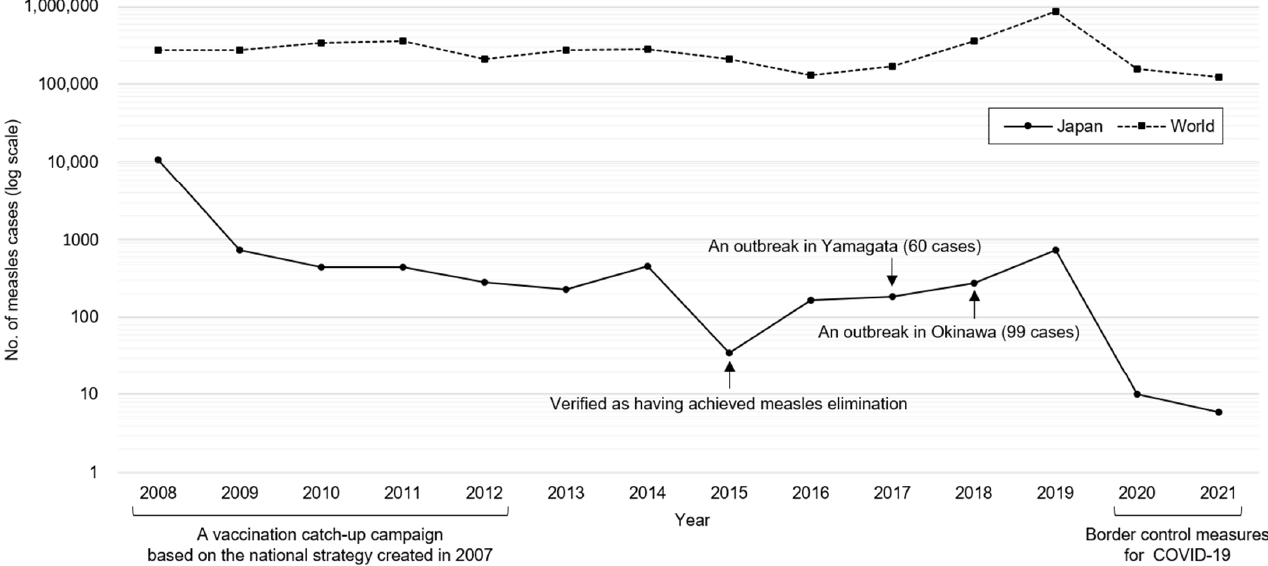
Figure 2. Number of measles cases worldwide and in Japan since 2008, when a notifiable disease surveillance in Japan was started, as well as relevant events in Japan [4,27]. The vertical axis is denoted by the log scale since the number of cases in Japan has declined sharply from 11,013 in 2008 to 6 in 2021. A vaccination catch-up campaign in Japan during 2008–2012 resulted in declining number of cases and Japan was verified as a country that has achieved measles elimination in 2015. Several large outbreaks have occurred thereafter [9,28], but the number of cases has decreased dramatically in 2020 and 2021 because of border control measures for COVID-19. During the period, the number of measles cases worldwide has been in the range of 124,041 (2021)–873,022 (2019)